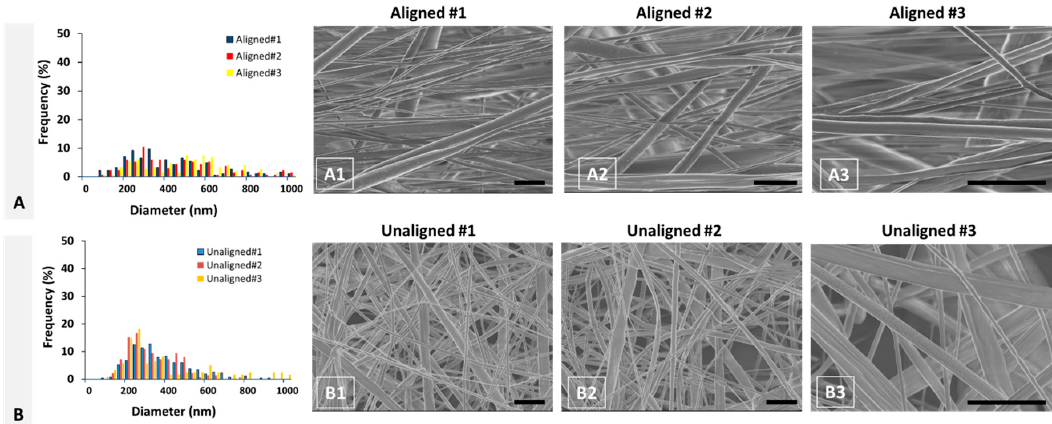
Figure 4. Diameter distribution of ( A ) aligned and ( B ) unaligned PCL fibers and respective ( A1 – A3 , B1 – B3 ) scanning electron microscopy (SEM) images. ( A1 – A3 ) correspond to individual specimens obtained from aligned PCL scaffolds ( n = 3). ( B1 – B3 ) correspond to individual specimens obtained from unaligned PCL scaffolds ( n = 3). Scale bar = 4 μ m. Molecules 2021 , 26 , x FOR PEER REVIEW